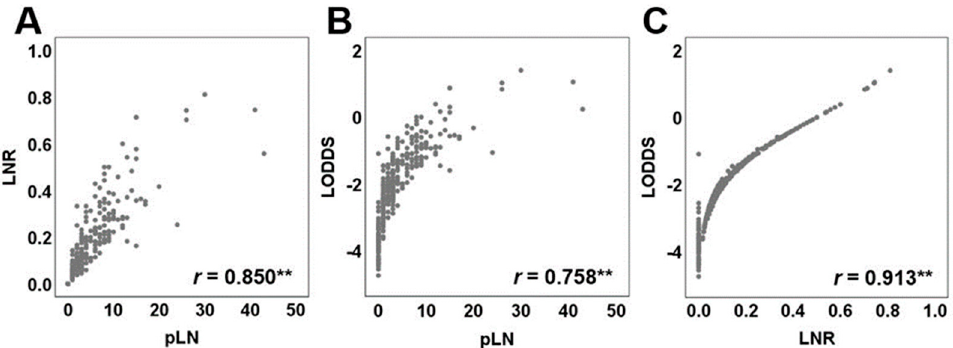
Figure 3. Relationship between positive lymph nodes (pLN), LNR, and LODDS. Scatter plots presenting the distribution of ( A ) LNR versus pLN, ( B ) LODDS versus pLN, and ( C ) LNR versus LODDS. ** p < 0.001.